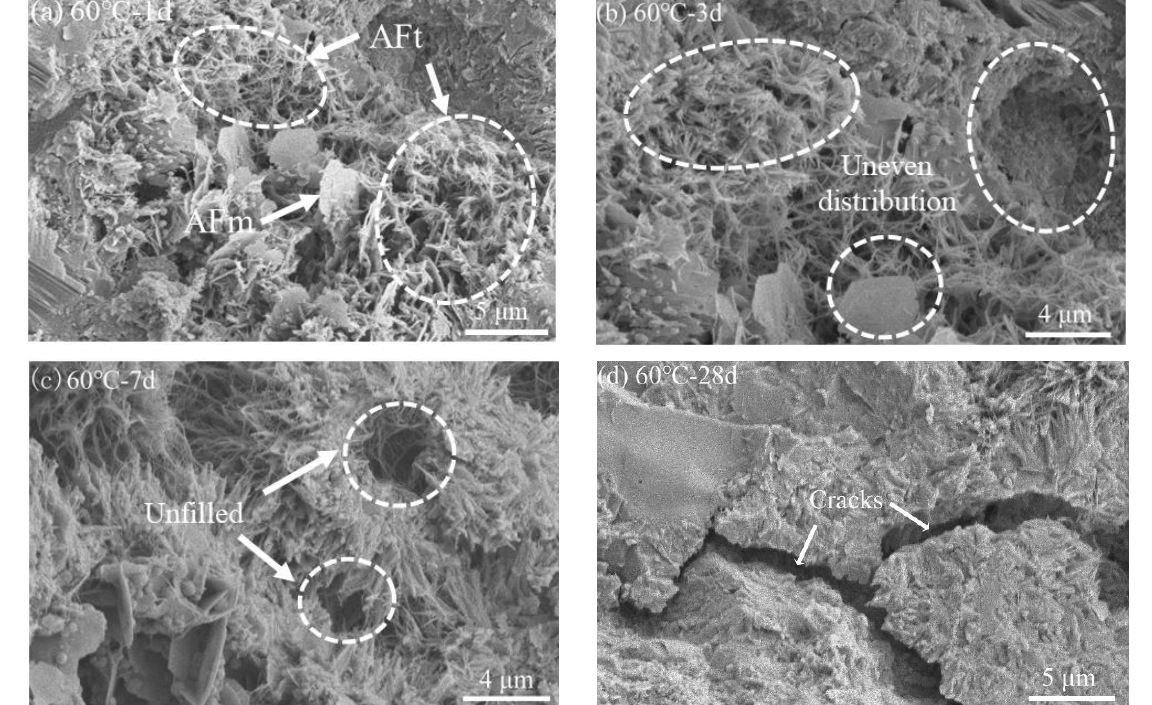
Figure 8. Microstructure of the SRPC at a curing temperature of 60 °C: ( a ) 1 d; ( b ) 3 d; ( c ) 7 d; ( d ) 28 d.